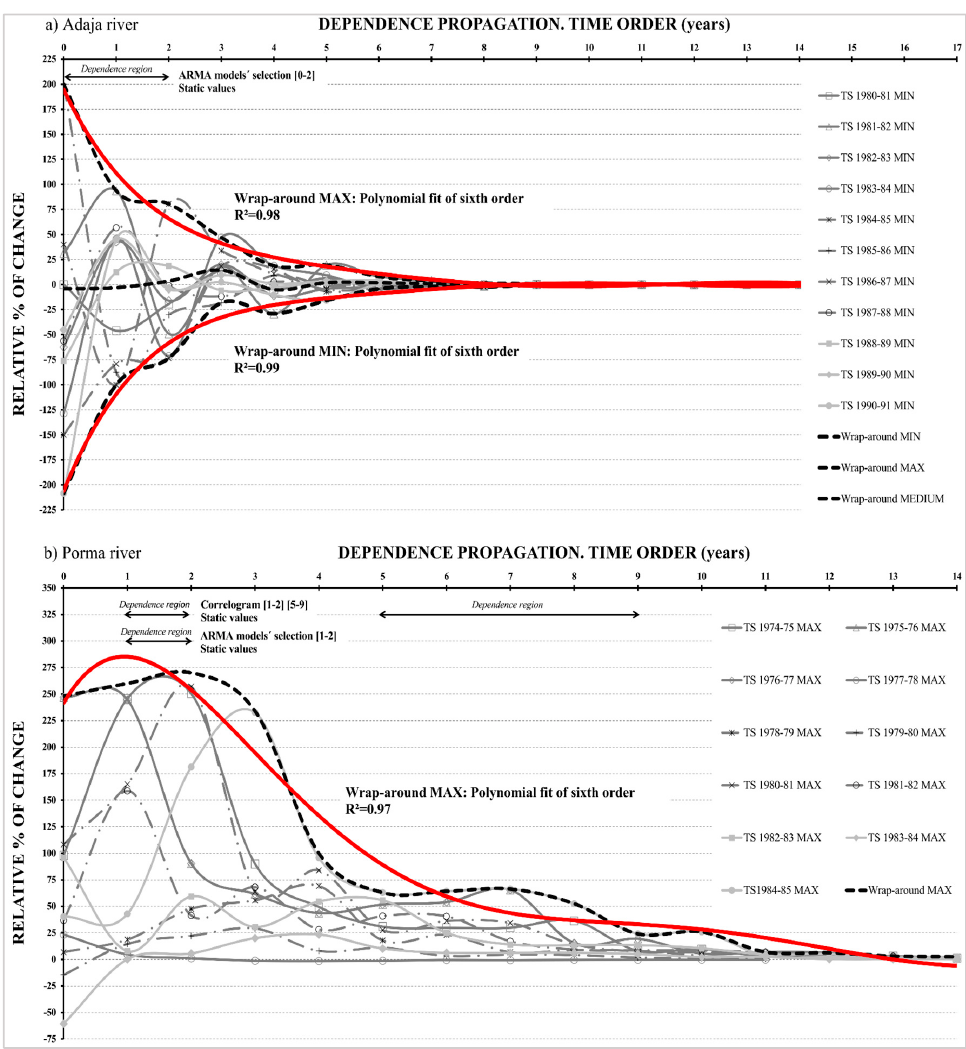
Figure 7. Temporal behavior results from the BN approach. ( a ) Adaja river; ( b ) Porma river. Note: Temporal dependence expressed as relative percentage of change.